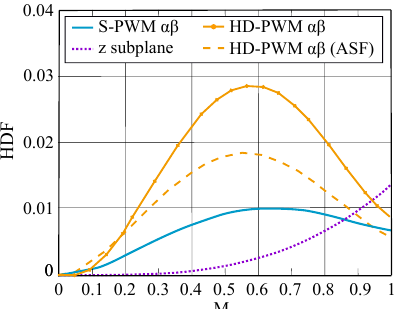
Figure 7. Harmonic distortion factor of S-PWM and HD-PWM schemes.